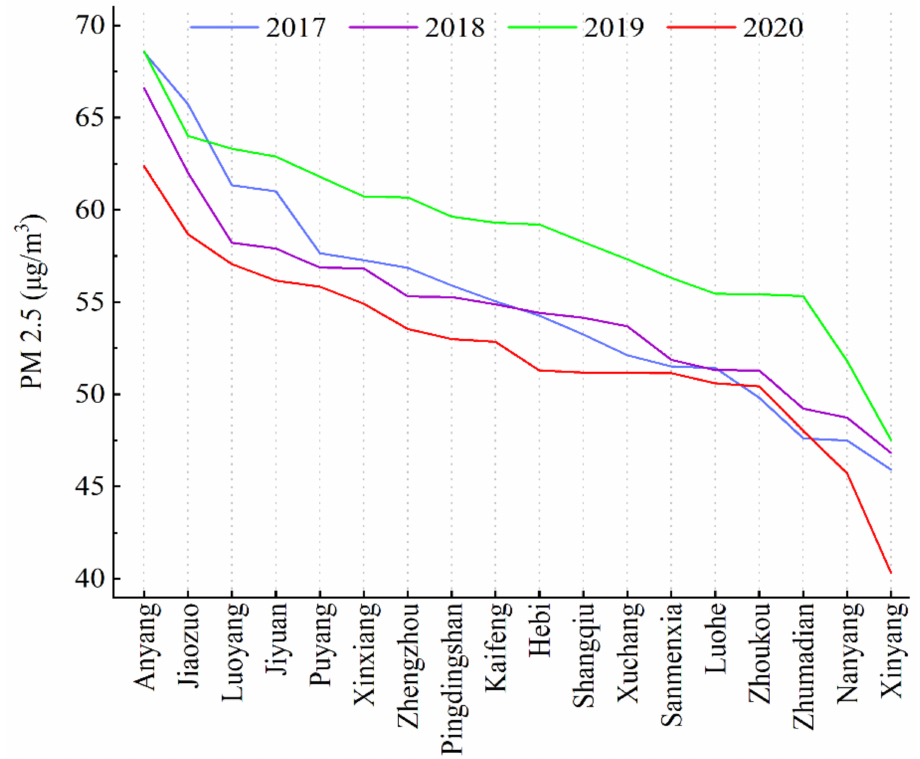
Figure 2. PM 2.5 concentration distribution trends in various cities of Henan